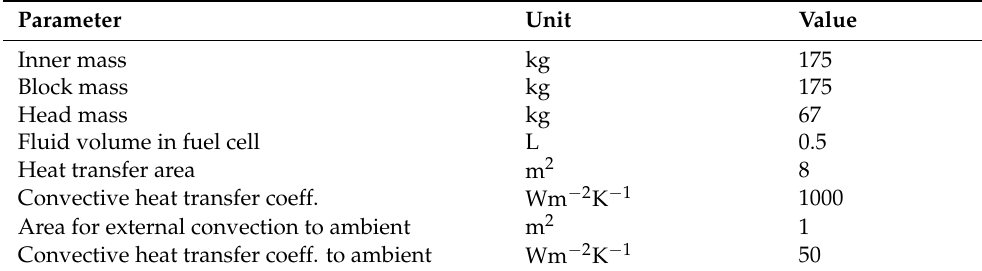
Figure 6. Illustration of the PEMFC model used for the 1D GT-SUITE model. ( a ) presents the layout of the thermal management system, whereas ( b ) presents the total Fuel Cell and management system as used in the GT-SUITE model. Table 5. PEMFC stack settings used in the study .